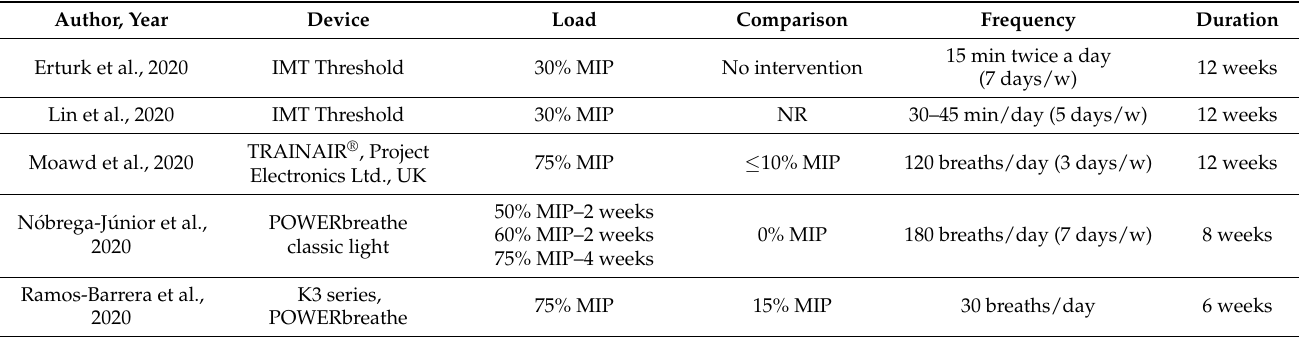
5 Table 2. Characteristics of respiratory muscle training programs. Author, Year